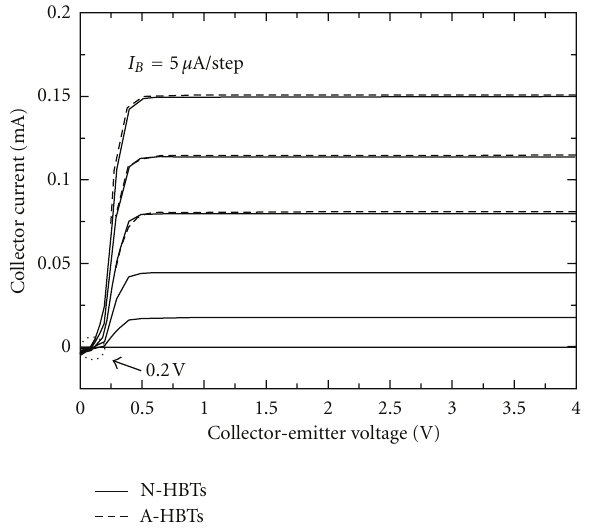
Figure 2: Measured collector current as a function of collector- emitter voltage for both N- and A-HBTs.